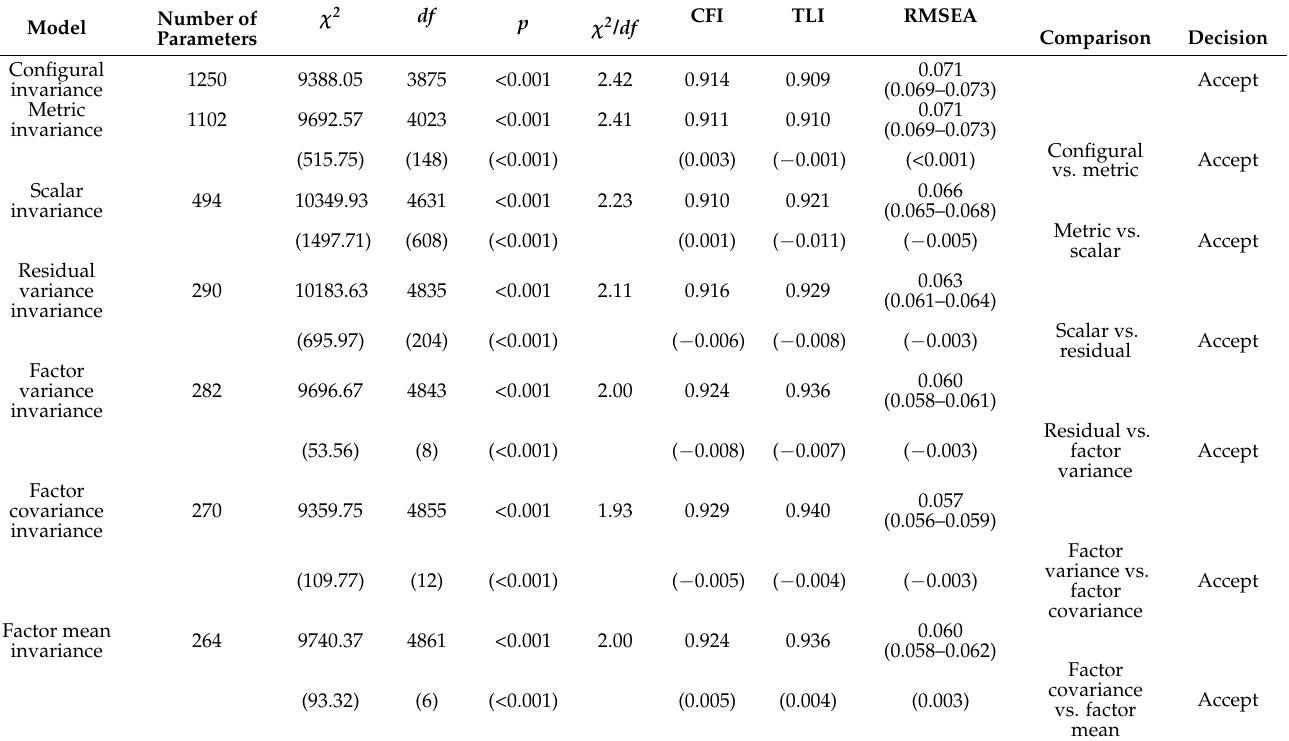
Table 7. MG CFA Results Using Fathers Samples from USA, South Africa, Nigeria, India, and